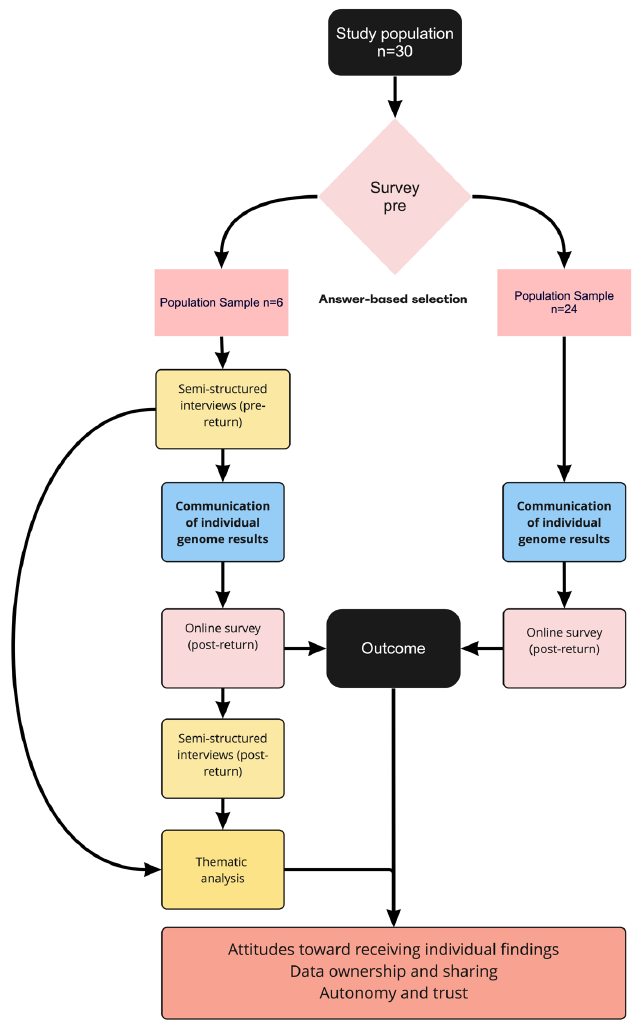
Figure 2. Overview of IAM Frontier survey and interview strategy (made in Miro).